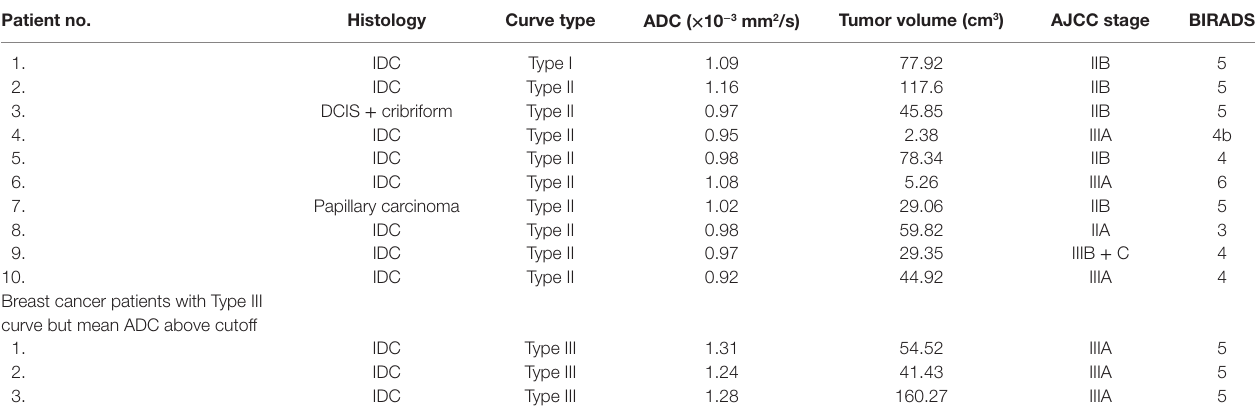
TaBle 5 | aDc value, histology, stage, volume, and BiraDs of breast cancer patients who showed Type i or ii curve on DceMri and those patients who showed aDc above the cutoff value. Patient no.